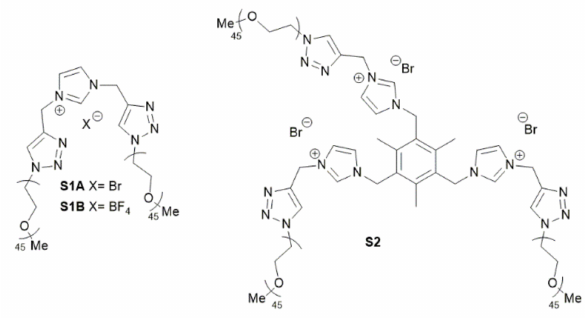
Figure 1. PEG-tagged imidazolium salts as stabilizers (previous work: Au NPs; this work: Rh